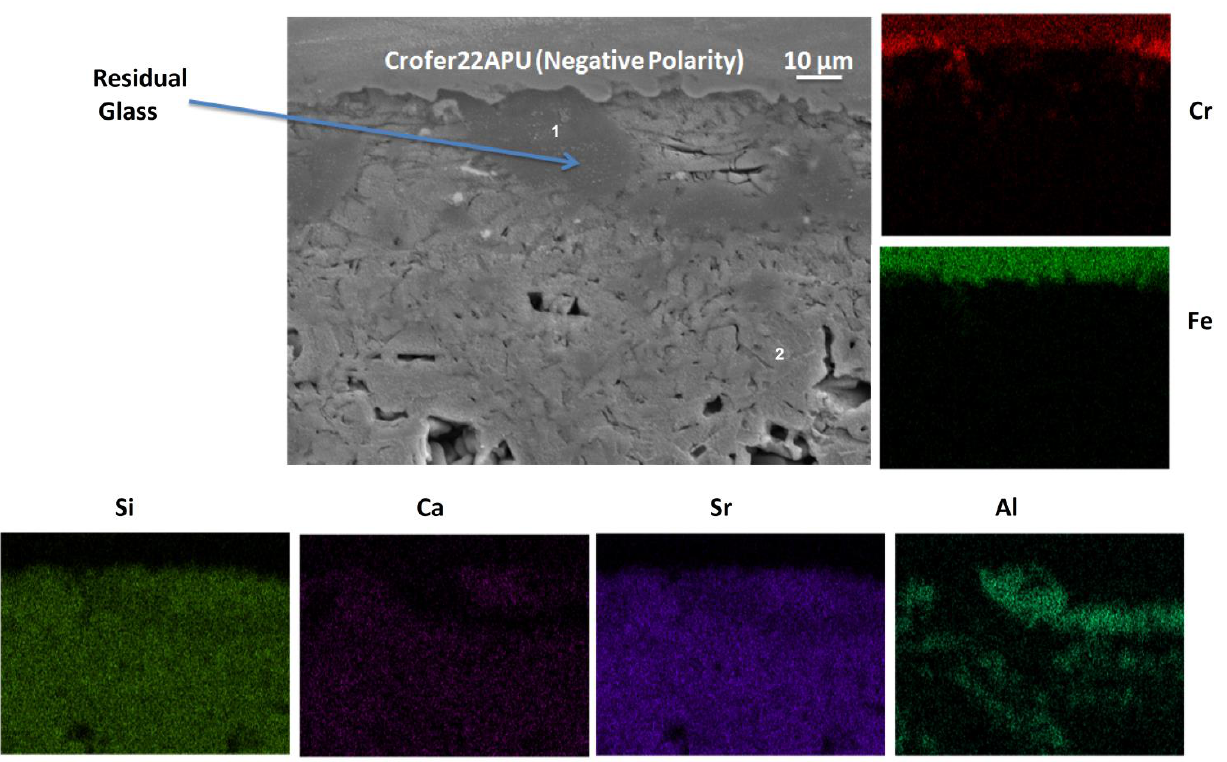
Figure 7. SEM image and EDS mapping of the air side of the negatively polarized Crofer22APU/HJ14 glass-ceramic interface. Table 5. EDS point analyses (at. %) performed on the air side of the HJ14 glass-ceramic bonded to the positively polarized Crofer22APU (analysis corresponds to Figure 7).